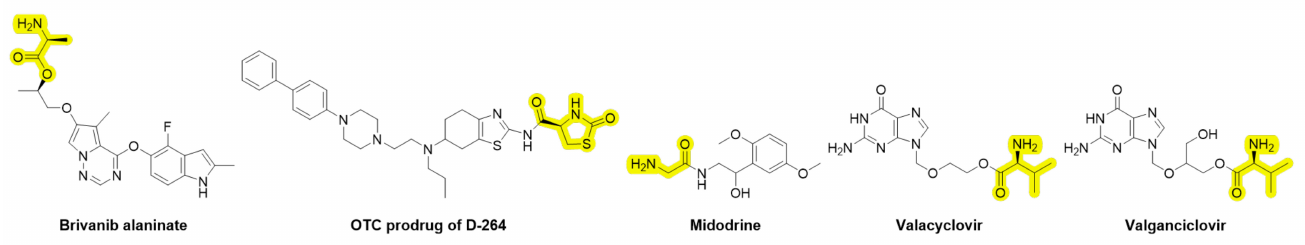
Figure 2. Molecular structures of proposed SLC1A prodrugs with the promoieties highlighted with yellow